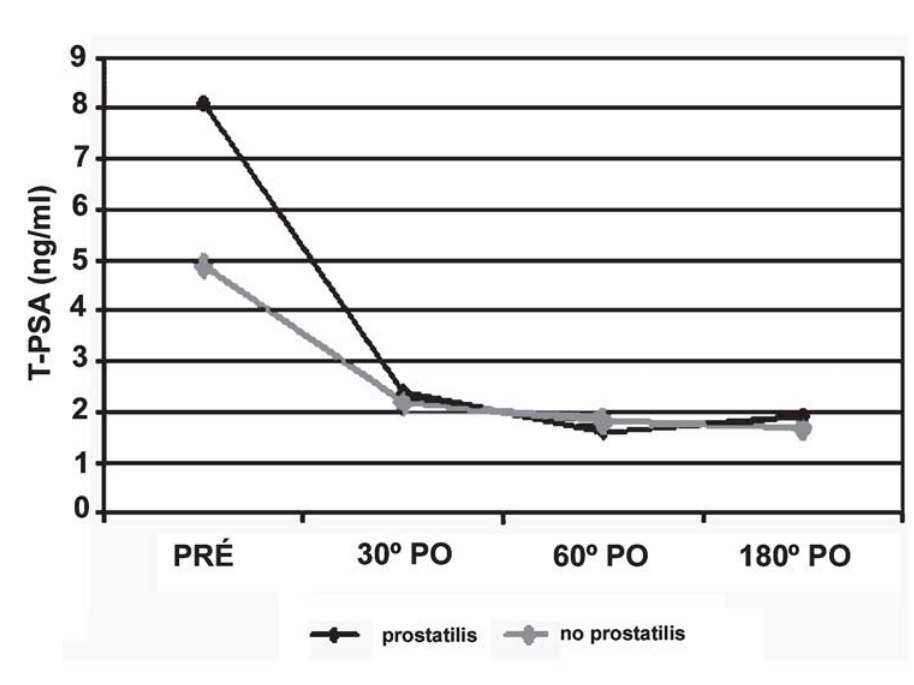
Figure 4 – T- PSA at baseline and postoperative days 30, 60 and 180 in patients with and without